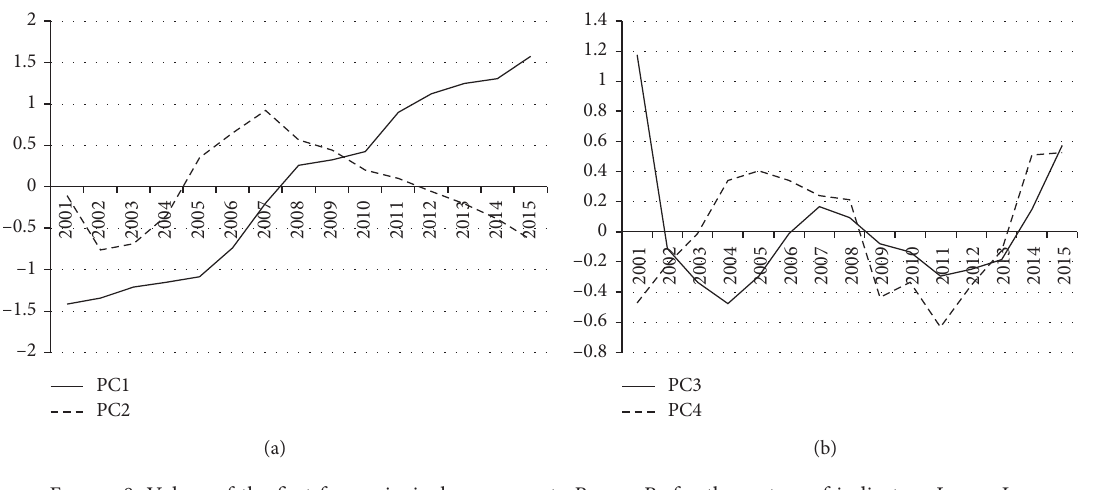
, ... , P for the system of indicators I 1 4